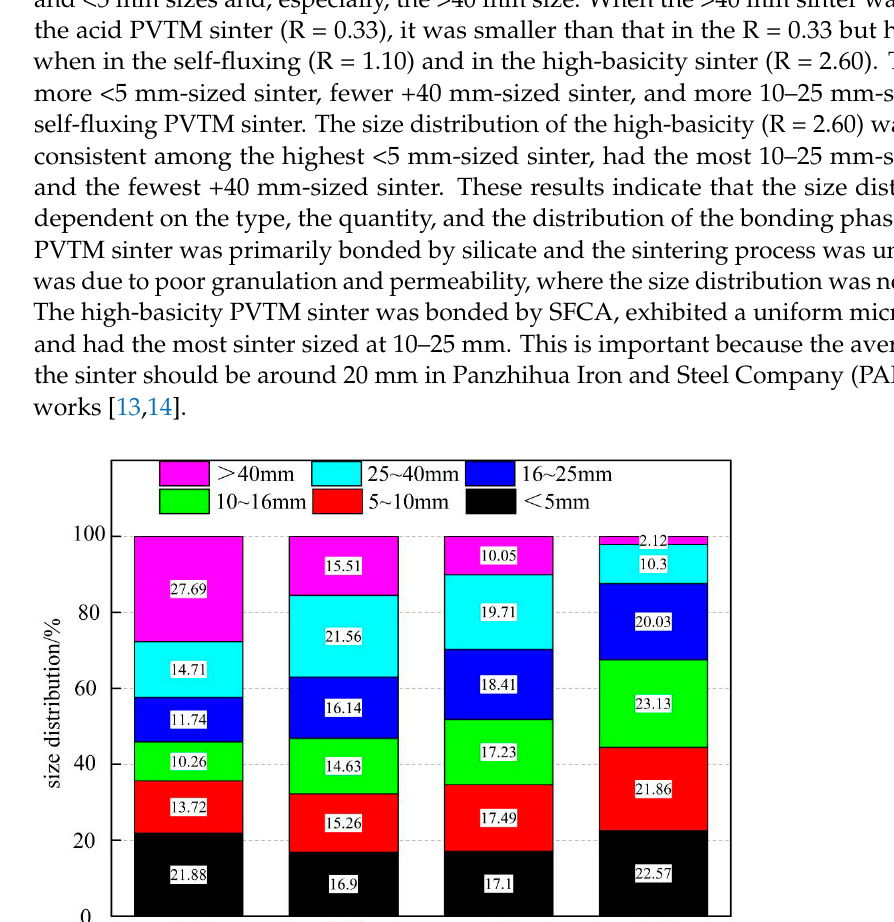
Figure 3. SEM Images of the four PVTM magnetite. ( a ) A ore; ( b ) B ore; ( c ) C ore; ( d ) D ore.